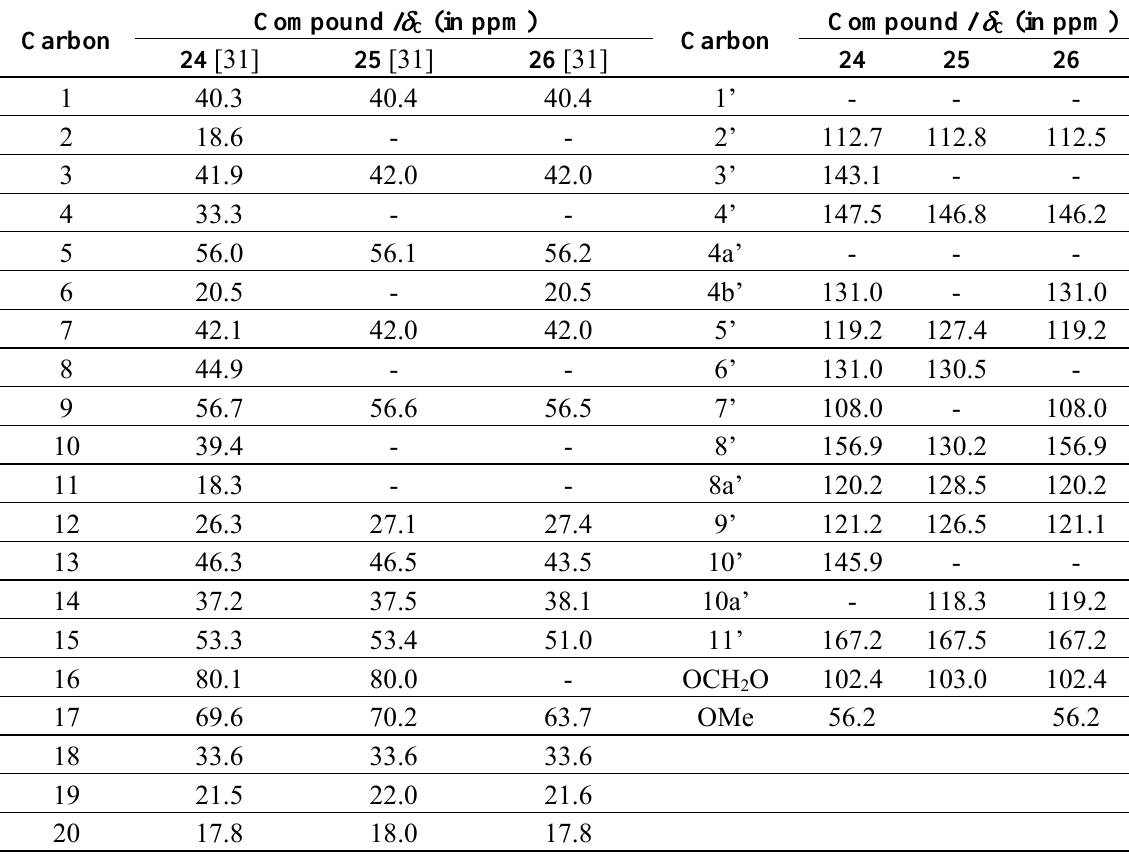
) of substituted diterpenes isolated from Aristolochia 3